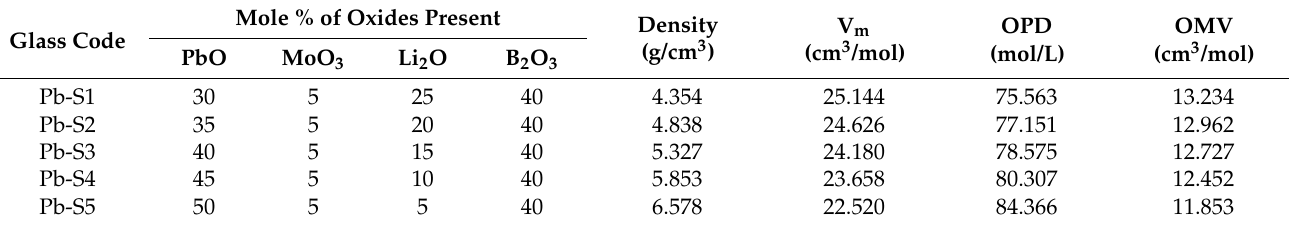
Table 1. Chemical composition and physical